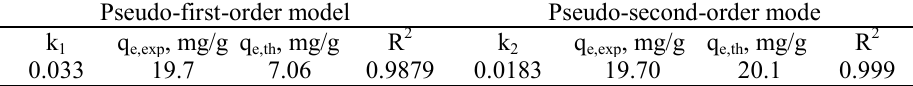
Table 2 . Parameters of pseudo-second-order model for U(VI) adsorption. Pseudo-first-order